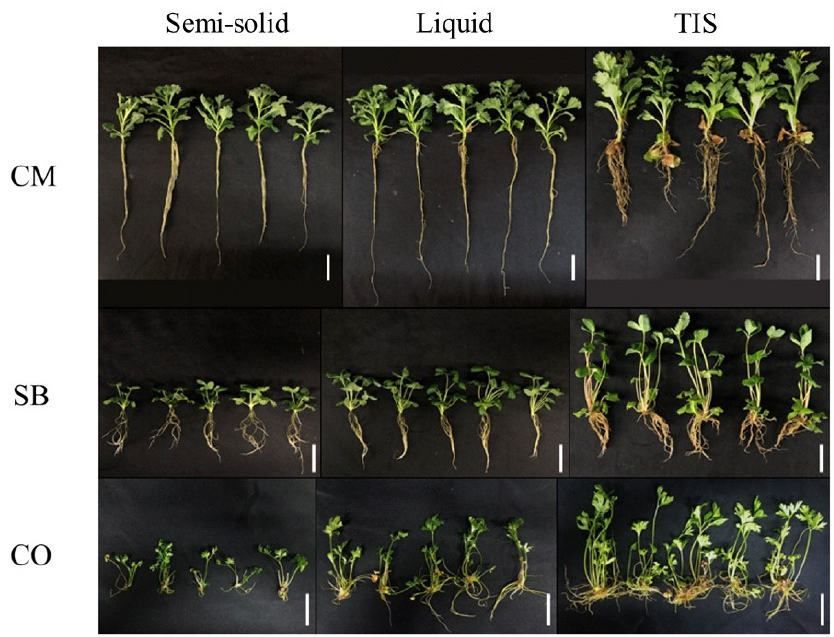
Figure 3. Harvested plants of chrysanthemum (CM), strawberry (SB), and Cnidium officinale (CO) plants from semi-solid, liquid, and TIS cultures. Scale bars = 3 cm.